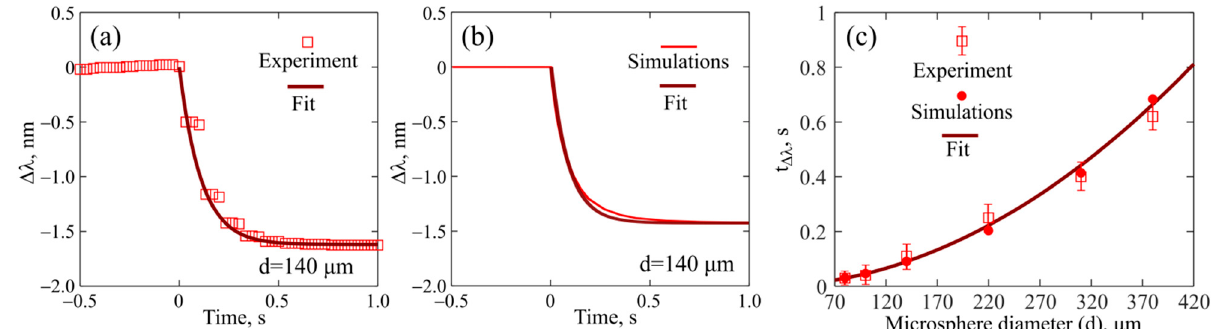
Figure 6. Experimental ( a ) and numerically simulated ( b ) dependences of thermo-optical shift in WGMs ∆ λ at time t . Thermalized power is 0.9 mW for t < 0 and the pump is switched off at t = 0. ‘Fit’ is approximation of ∆ λ by exponential decay with characteristic time t ∆ λ for t > 0; ( c ) t ∆ λ dependence on microsphere diameter obtained by experimental measurements, by direct simulations and fitted by t ∆ λ = C 2 · d 2 , where C 2 = 4.6 × 10 − 6 s · µ m − 2